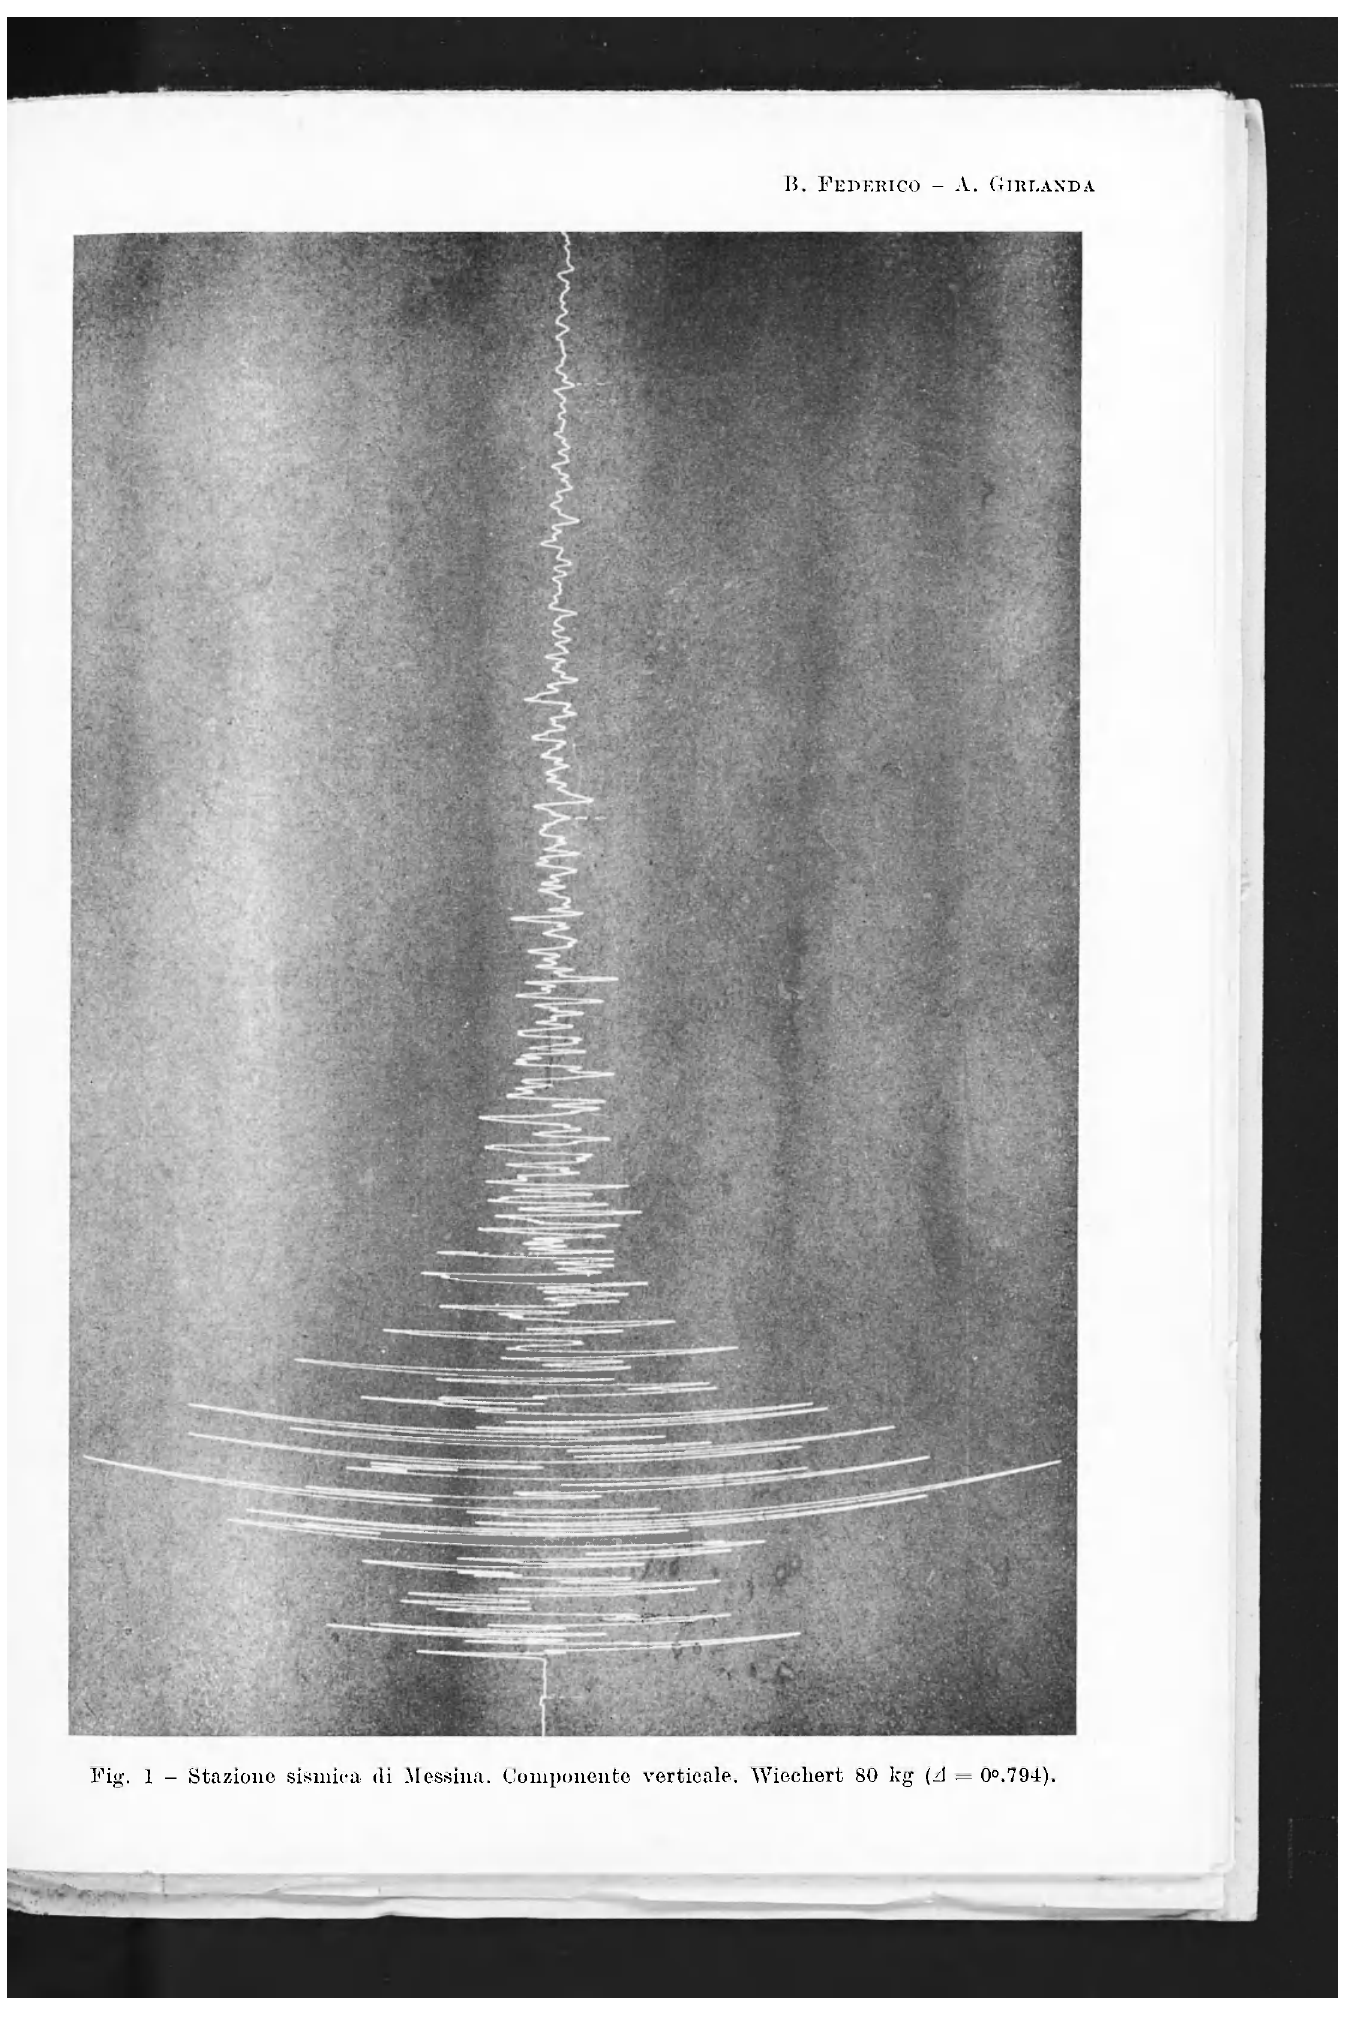
Fig. 1 - Stazione sismica di Messina. Componente verticale. Wiecliert 80 kg {A =